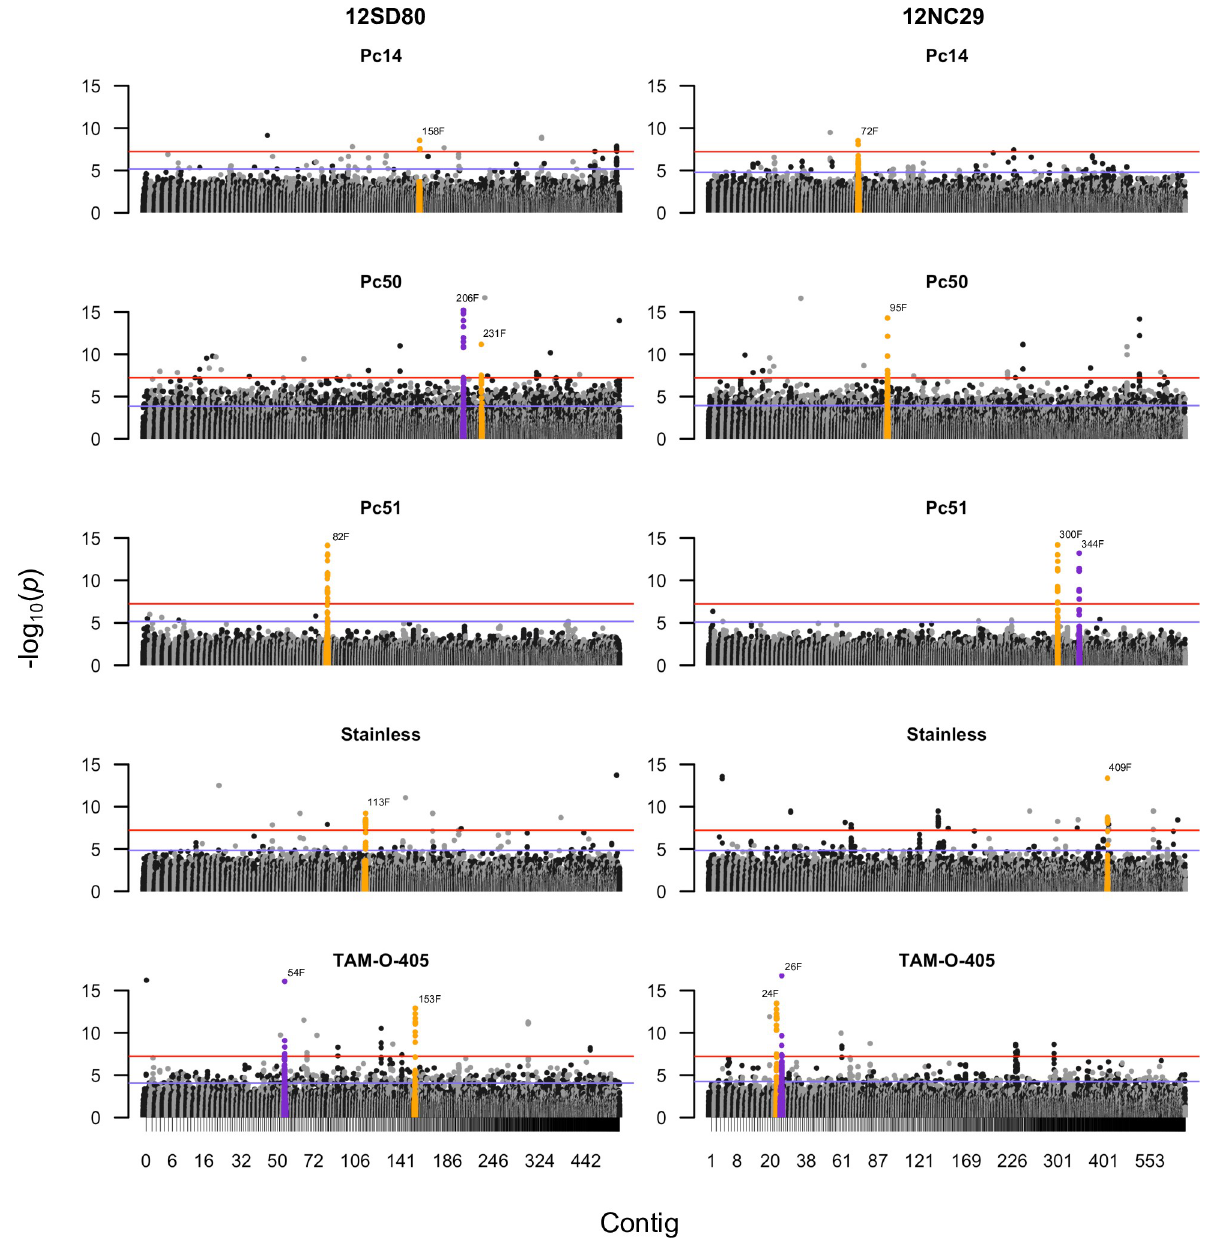
Fig 3. GWAS for virulence of Pca towards oat differential lines. Manhattan plots showing SNP association values for virulence to oat lines Pc14 , Pc50 , Pc51 , Stainless and TAM-0-405 across primary contigs in the 12SD80 and 12NC29 genome assemblies. Highlighted SNPs in orange are derived from contigs with significant association peaks and containing predicted effector genes, whereas SNPs in purple are derived from significant contigs without any predicted effector genes. Red and blue horizontal lines denote Bonferroni significance threshold ( α = 0.05/total number of markers) and 5% false discovery rate threshold, respectively.